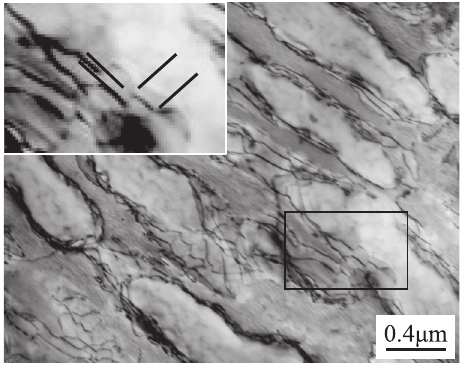
Fig. 5: Dislocations climbing on {1 1 1} crystal planes along < 1 1 0 > direction